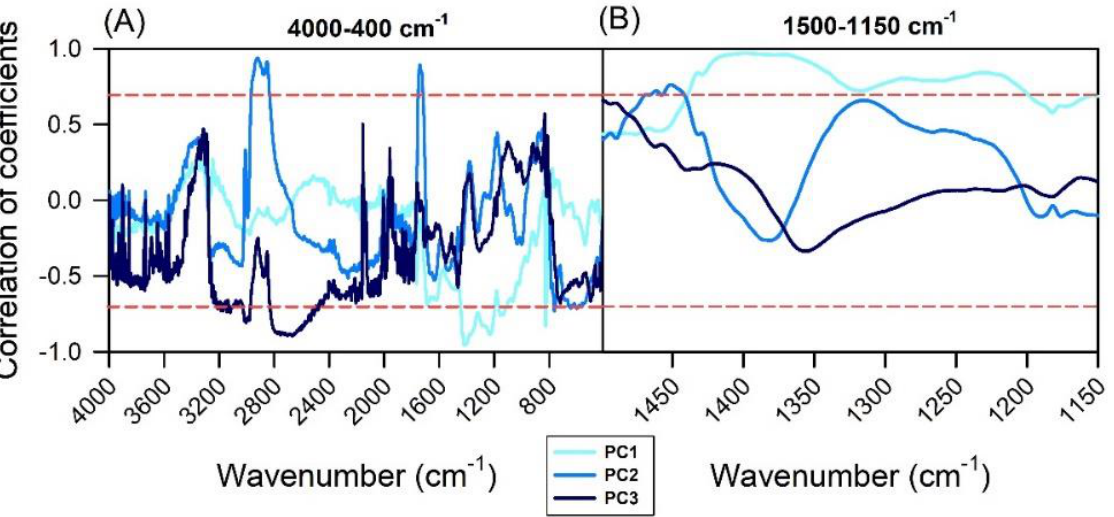
Figure 5. Correlation coefficients with the three principal components (light to dark blue lines, PC1, PC1, and PC3). ( A ) 4000-400 cm −1 by ATR-FTIR measurements. ( B ) 1500-1150 cm −1 by ATR-FTIR measurements. The red line indicates − 0.70 and 0.70 correlation of coefficients.